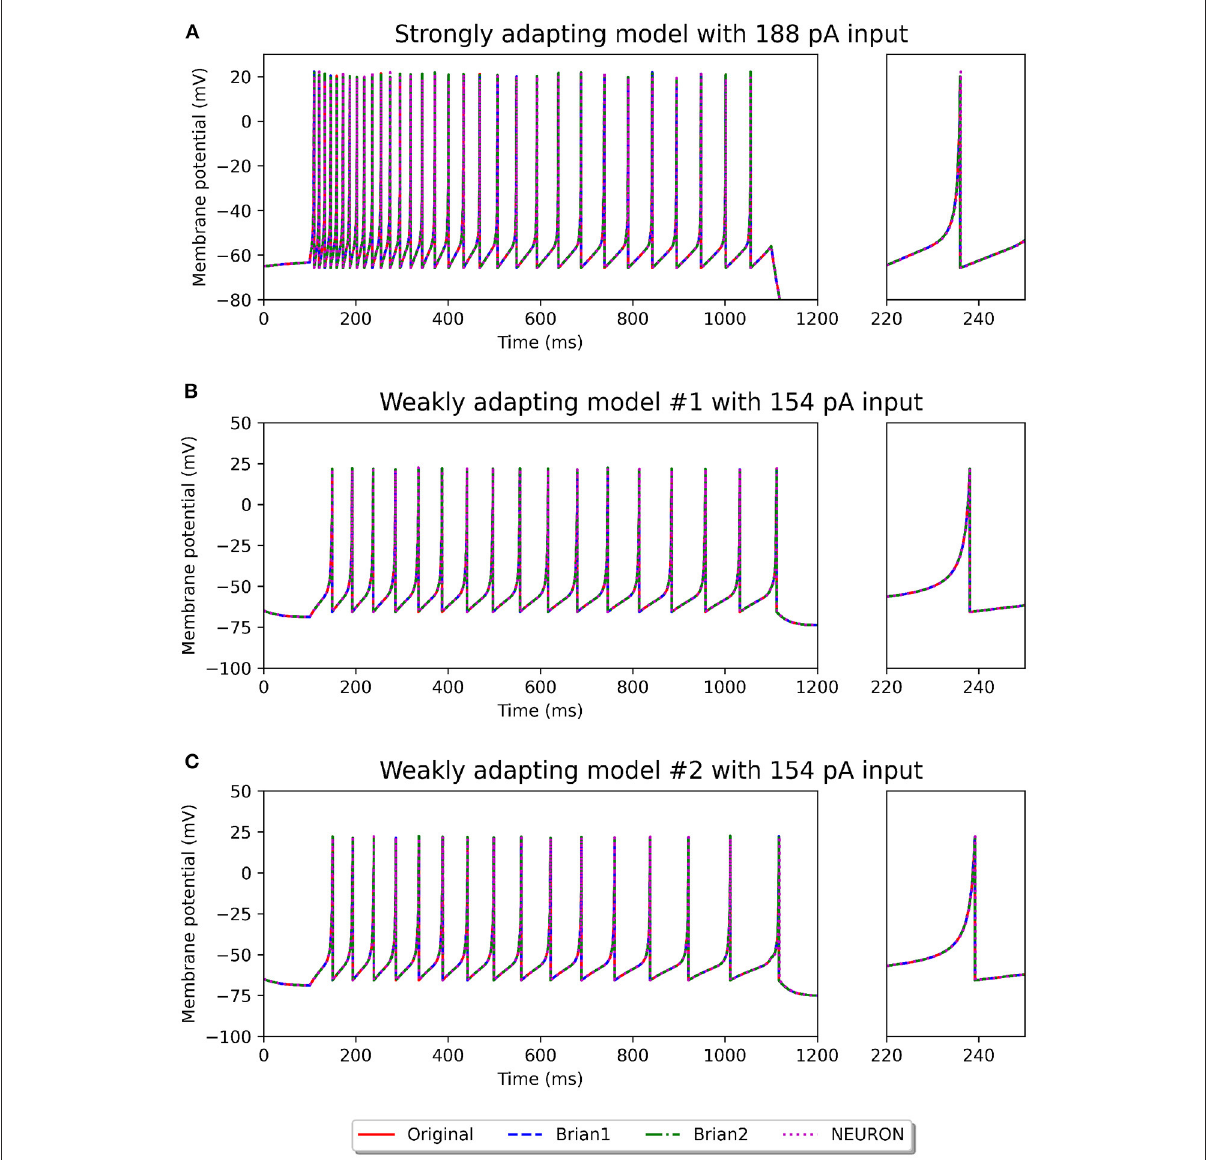
FIGURE2 Spiking activity observed in the different model variants following a depolarizing stimulus. The stimulus strengths were chosen based on the examples in the original study: 188 pA stimulus for the strongly adapting models (A) , and 154 pA stimulus for the weakly adapting models (B,C) . The differences in adaptation is easily noticeable. The smaller panels on the right provide a closer view of one of the spikes in the recording.